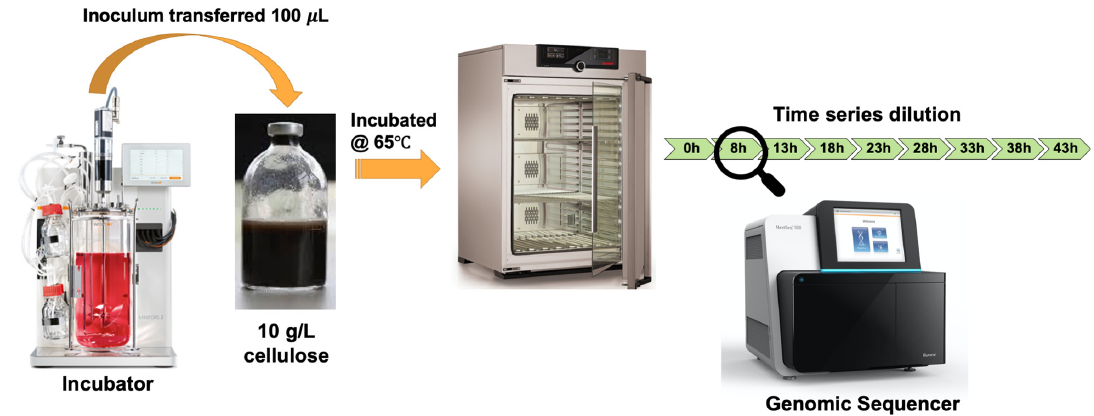
Figure 3. Graphical representation of Biogas reactor Dataset. A 100 µl inoculum was collected from a lab-scale biogas reactor incubated at 55 °C and transferred to an anaerobic flask containing 10 g/L of cellulose. Triplicate mRNA samples were taken in a time series from 0 to 43 hours after inoculation. Metagenomic and metaproteomic sequencing was performed for all time points. For this tutorial we used one of the triplicates (T1A) in the 8 hours’ time